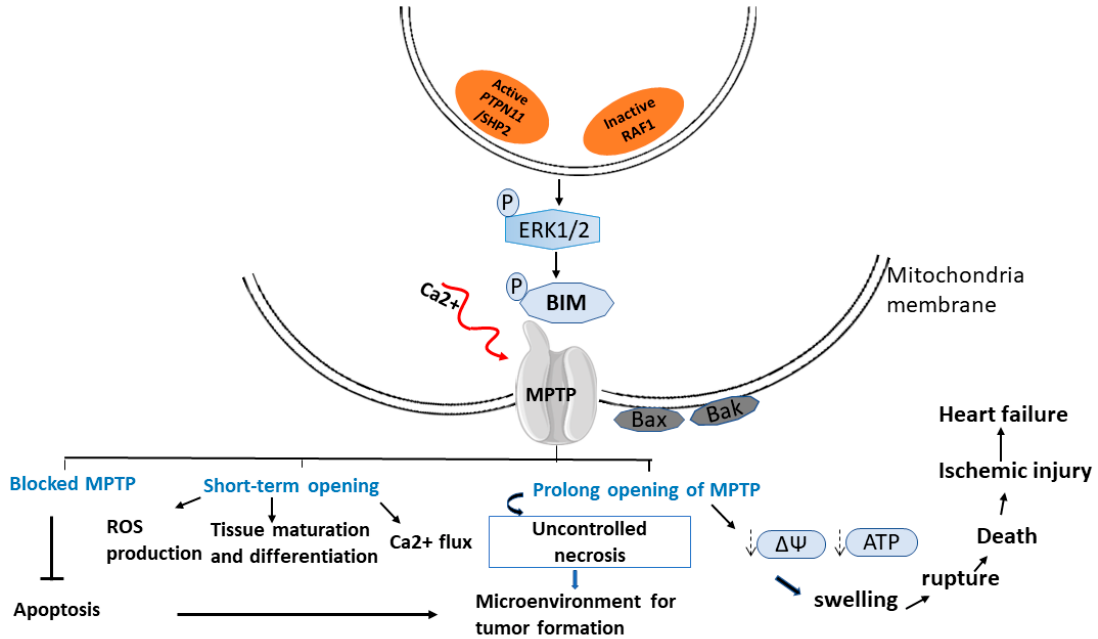
Figure 4. Effect of PTPN11 and RAF1 mutation on mitochondria permeability transition pore (mPTP). Upon PTPN11 activation or RAF1 inactivation, ERK signalling is phosphorylated, in turn phosphorylating and activating apoptotic regulators such as Bcl-2-like protein 11 (BIM); Bcl-2-like protein 4 (Bax), and Bcl-2 homologous antagonist/killer (Bak) localized on the mitochondrial mem- brane. This event destabilizes the opening and closure of the mitochondria permeability transition pores (mPTP), causing a blocked or prolonged opening state of the membrane channels. Thus, a huge efflux of Ca2+ (prolong state) is observed, resulting in decreased mitochondrial membrane potential and altered and uncontrolled cellular